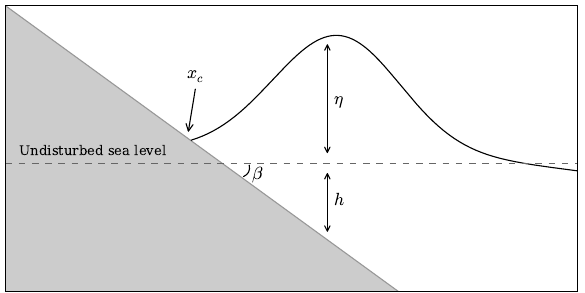
Fig. 1. Benchmark n. 1: definition sketch, where η is the water ele- vation, h is the water depth, x c is the coastline position and β is the slope